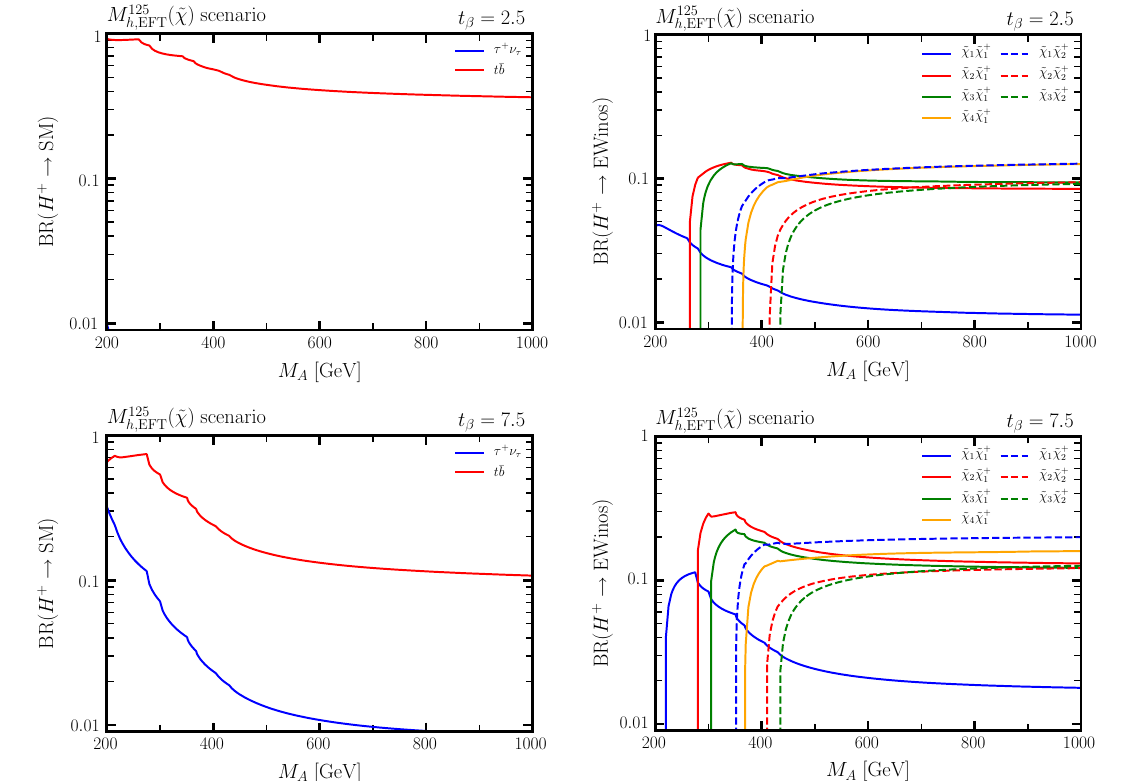
( ˜ χ) scenario as a function of M β = 2 . 5 A , for fixed tan h , EFT